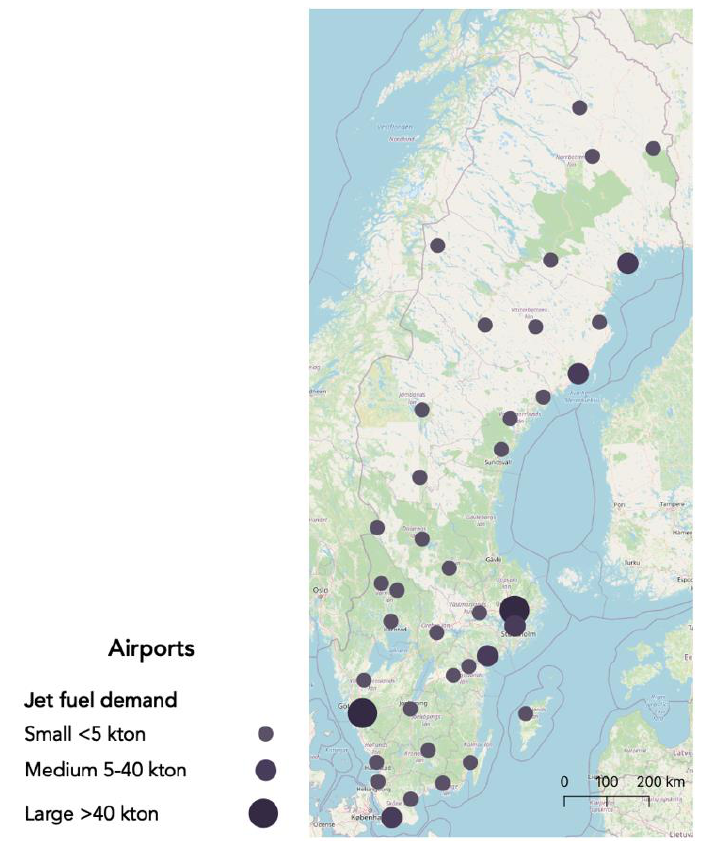
Figure 5. Airport locations in Sweden and annual jet fuel demand. Base map data © OpenStreetMap contributors, available under the Open Database License, terms further described in [106]).